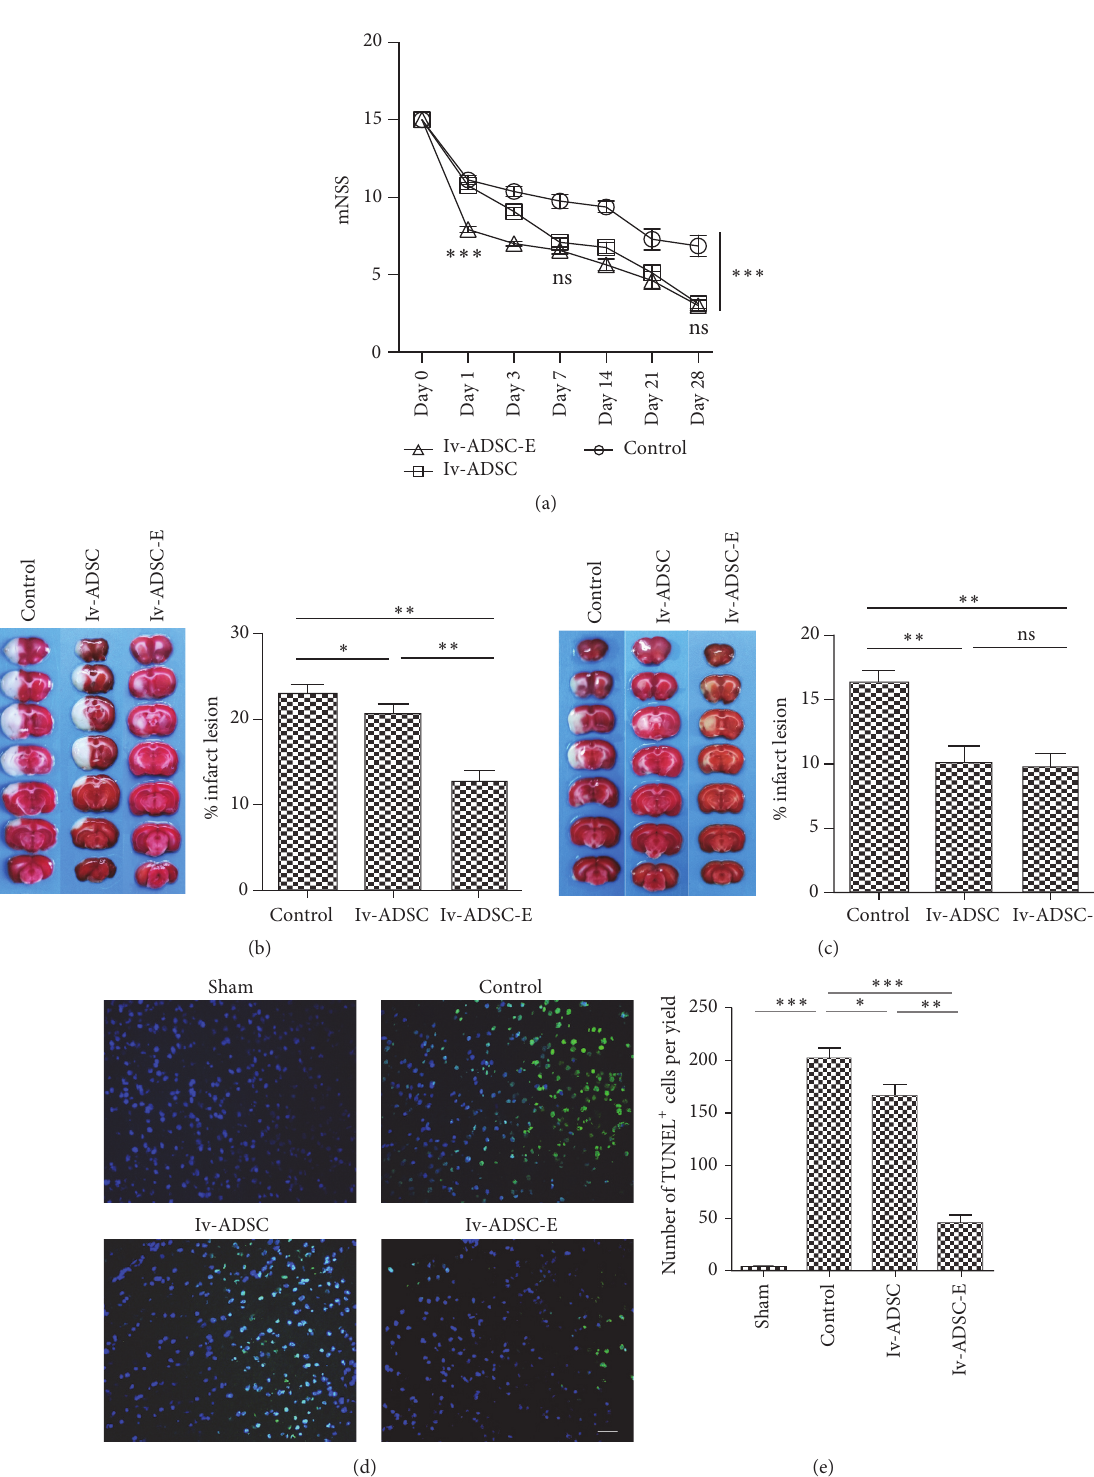
Figure 3: Different therapeutic characteristics between ADSC and ADSC-E on stroke. tMCAO was induced using SD rat. Either ADSC or ADSC-E was injected through IV. (a) The neurological deficits were graded based on mNSS scaling system ( 𝑛 = 8 /group). (b, c) TTC staining was used to quantify the volume of infarct area at either Day 1 ( 𝑛 = 6 /group) (b) or Day 7 ( 𝑛 = 6 /group) (c). (d, e) TUNEL staining was used to measure apoptotic neurons. Scale bars: 100um (e). Five sections from each rat were selected ( 𝑛 = 3 /group). For each section, TUNEL positive neural cells were counted from 3 separated yields. ANOVA was used to analyze the data. ∗ 𝑝 < 0.05 , ∗∗ 𝑝 < 0.01 , and ∗∗∗ 𝑝 < 0.001